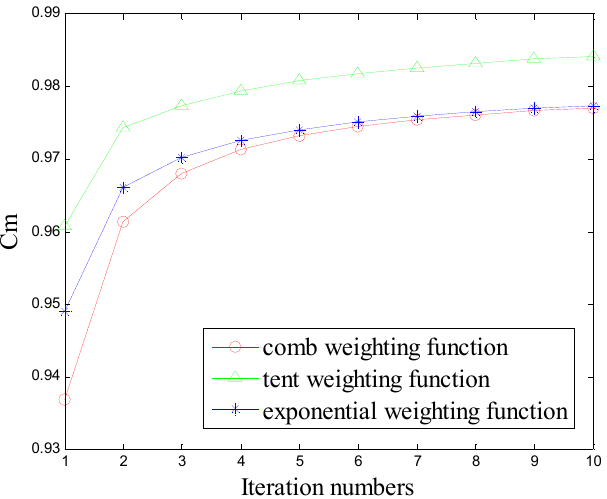
Figure 1. Signal to noise ratio (SNR) values along with iterations.